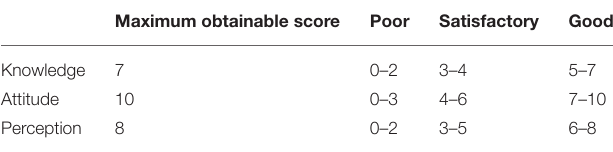
TABLE 1 | Numeric scoring pattern. TABLE 2 | Demographics of sample showing age, gender, province and year of